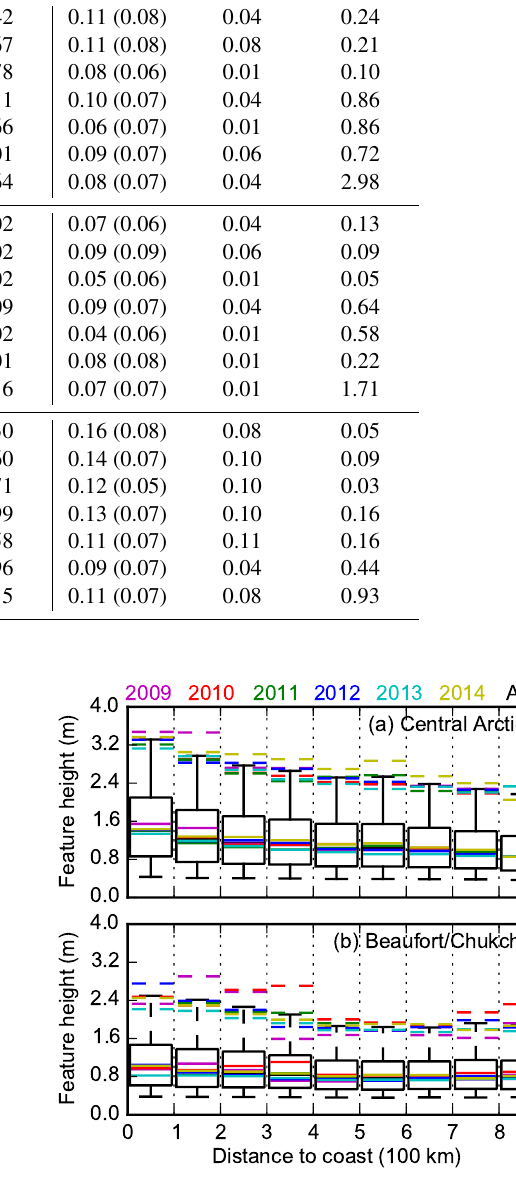
Figure 10. Surface feature height, h f , as a function of distance to the nearest coastline within the (a) Central Arctic and (b) Beau- fort/Chukchi regions (given in Fig. 5), presented using box and whisker plots (5, 25, 50, 75, 95 percentiles). The coastline distance bin width is 100km. The black boxes (and whiskers) show the re- sults from all features detected in each region, while the colours represent the results from each